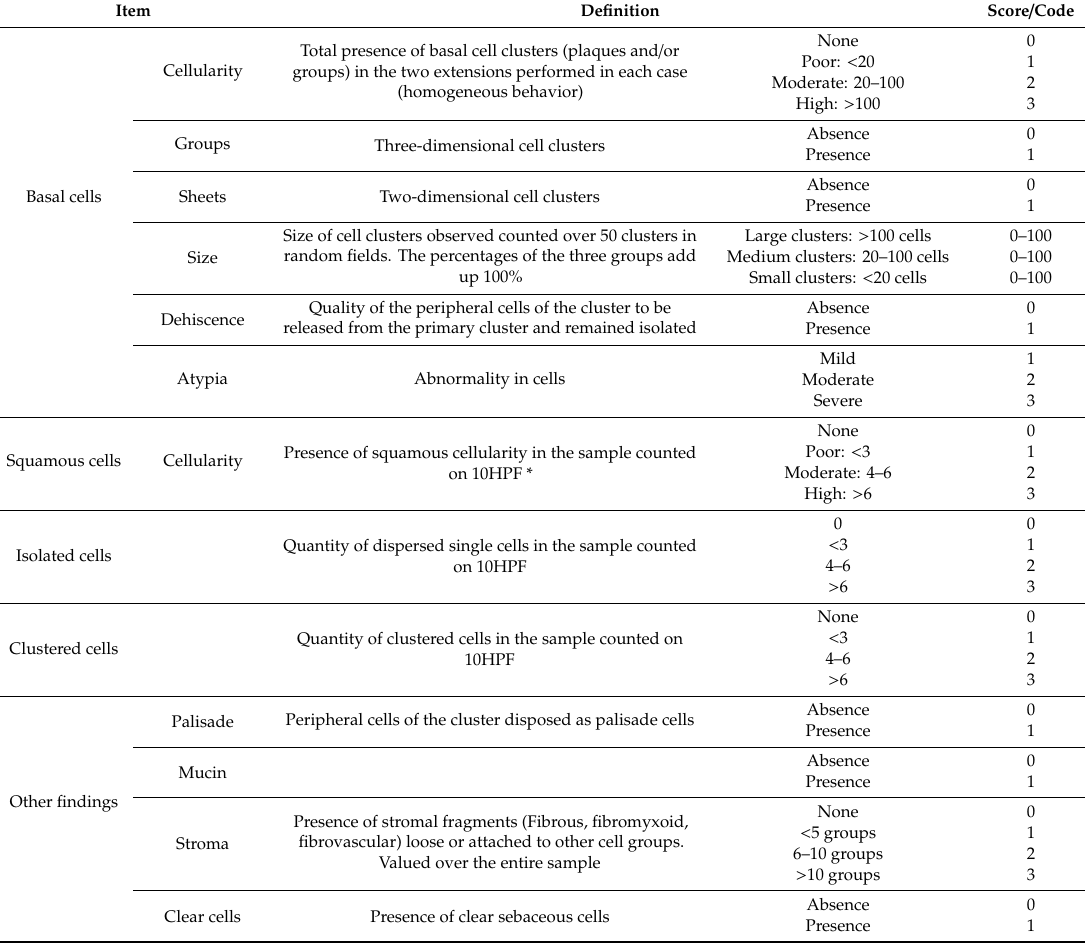
Table 1. Cytological features of skin tissue scoring system